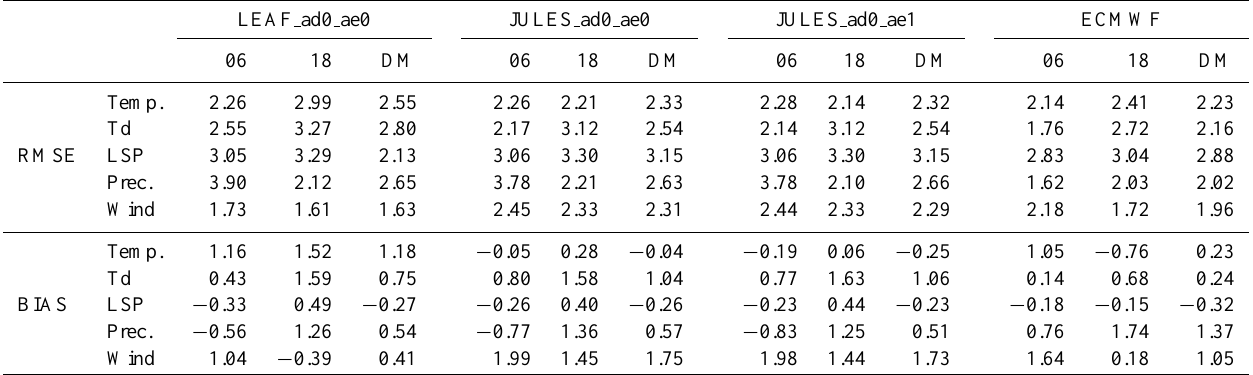
Table 4. Error values for the night period (06:00UTC), daytime period (18:00UTC) and daily mean (DM) for the dry season (September 2010). LEAF ad0 ae0 JULES ad0 ae0 JULES ad0